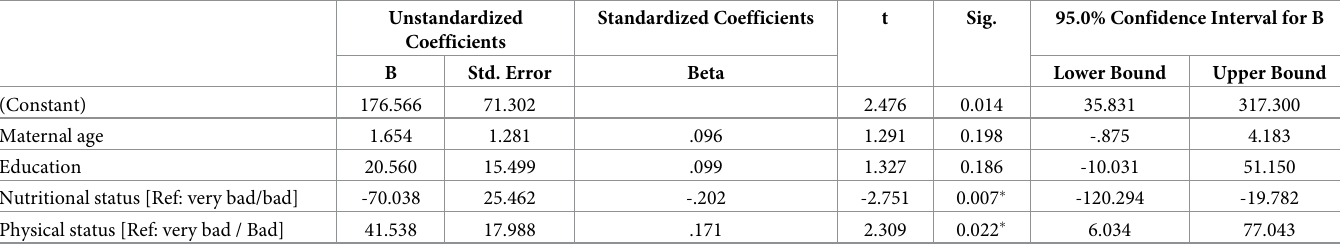
Table 7. Multiple regression analysis of explanatory factors associated with the total score of PPAQ in